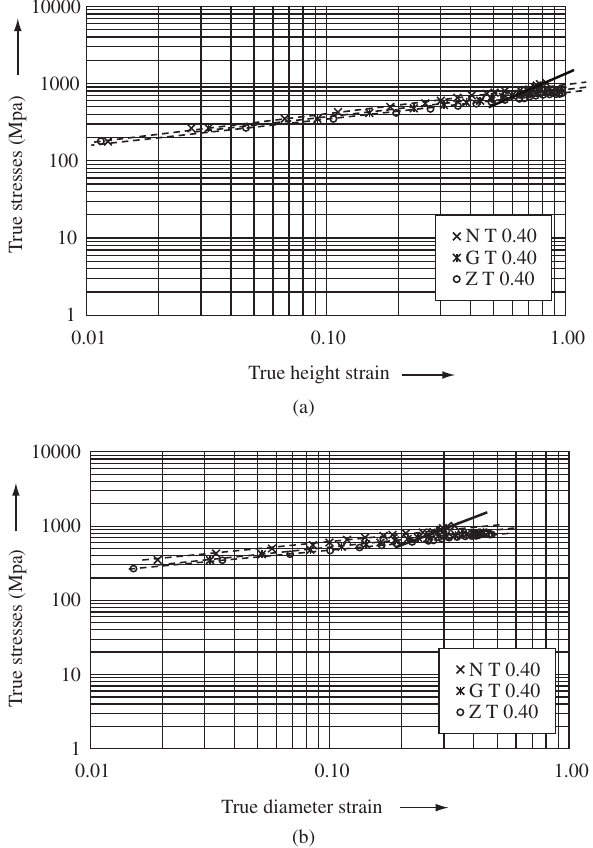
Figure 4. a) Flow curve between true stresses and true height strain in log, log scale; and b) Flow curve between true stresses and true diameter strain in log, log scale. Dashed line: Segment 1; Continuous line: Segment